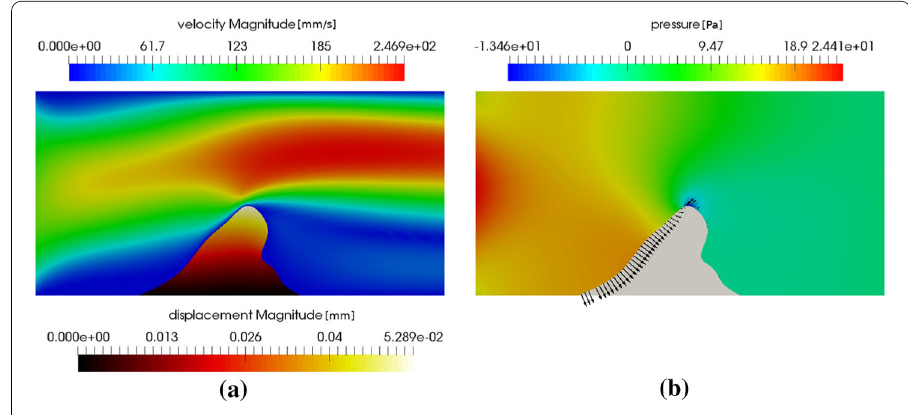
Fig. 2 Field solutions of the reference simulation illustrating the deformed geometry. a Fluid velocity magnitude and structure displacement magnitude. b Fluid pressure solution and interface tractions on the biofilm as black arrows